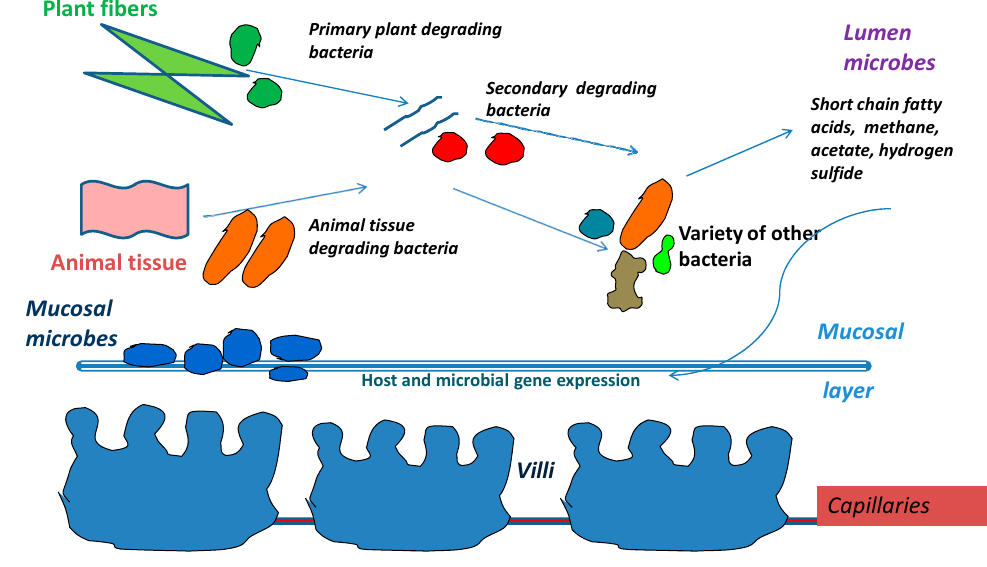
Figure 2. Simplified version of microbial community interactions. The intestinal wall is at the bottom, with villi and blood supply which brings oxygen to the intestinal wall. The top of the figure illustrates the mid-section / lumen of the intestine which has low oxygen supply but a higher supply of hydrogen sulfide from the sulfate reducing bacteria living in the